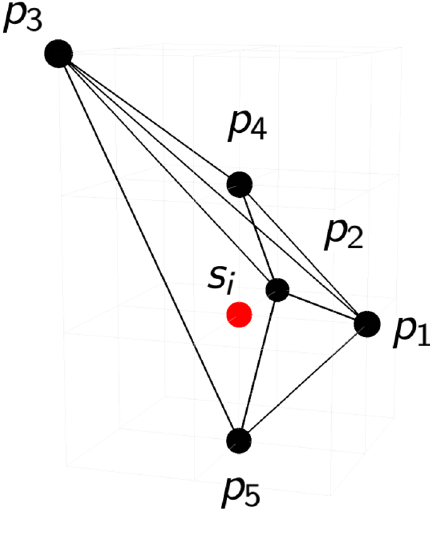
Figure 19 . Toric diagram for Model